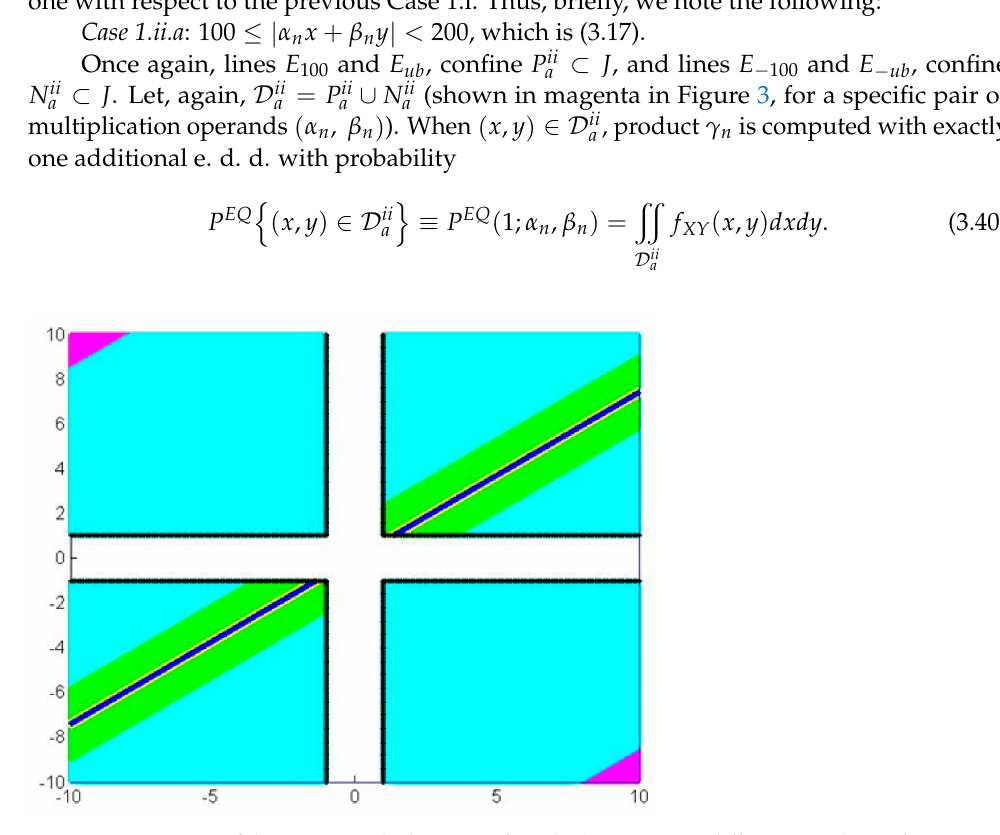
Figure 3. Depiction of the various sub-domains of J , which give rise to different numbers of erroneous decimal digits of γ 5 = α 5 β 5 , where | man ( α 5 ) man ( β 5 ) | ≥ 10. In this example, we have selected α 5 = 4.6812 and β 5 = − 6.3178: therefore (a) the sub-domain generating one additional e. d. d. is depicted in magenta, (b) the sub-region that does not increase the f. p. error is shown in cyan, (c) the sub-domain relaxing the e. d. d. number by one is depicted in green, (d) the one relaxing the number of e. d. d. by two is shown in yellow, while (e) the one relaxing the number of e. d. d. by three is depicted in blue. The sub-domains that represent an even greater relaxation of the f. p. e. are too small to